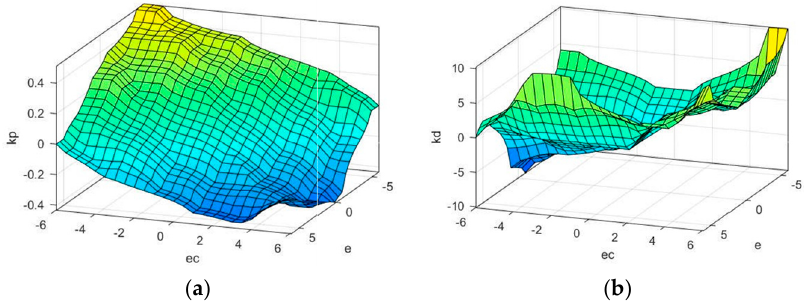
Figure 11. output surface: ( a ) K P surface and ( b ) K D surface. Figure 11. Output surface: ( a ) K P surface and ( b ) K D